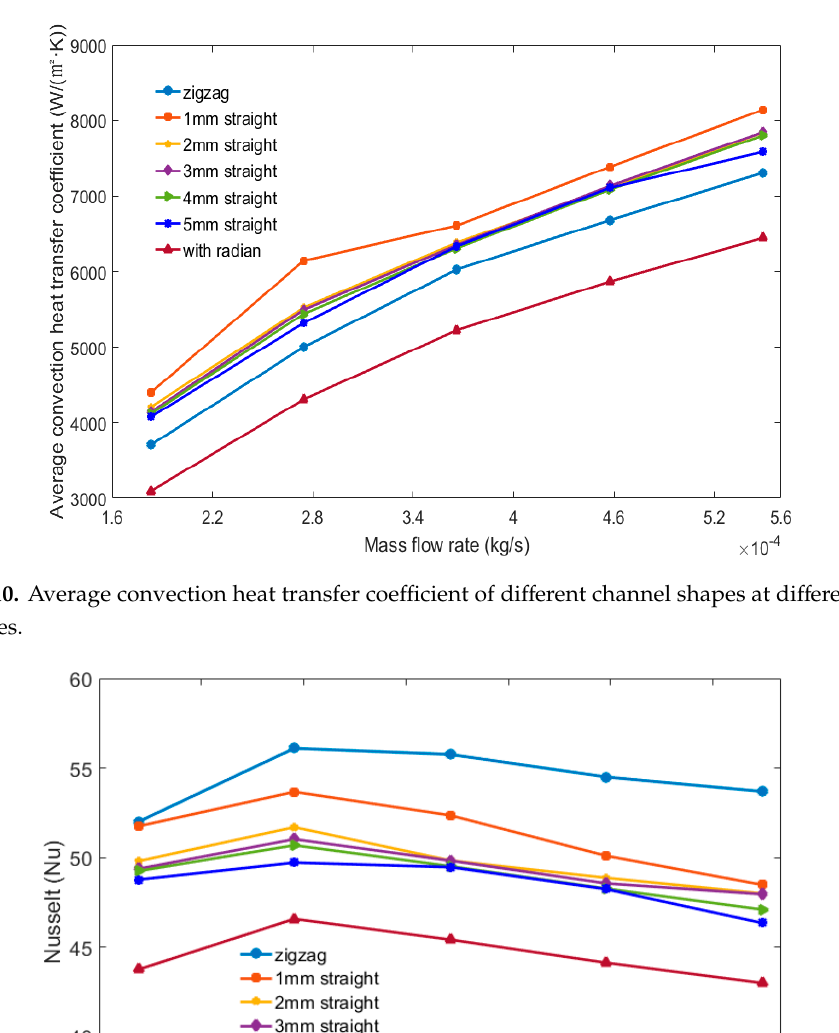
Figure 12. Total pressure drops for different channel shapes at different mass flow rates.